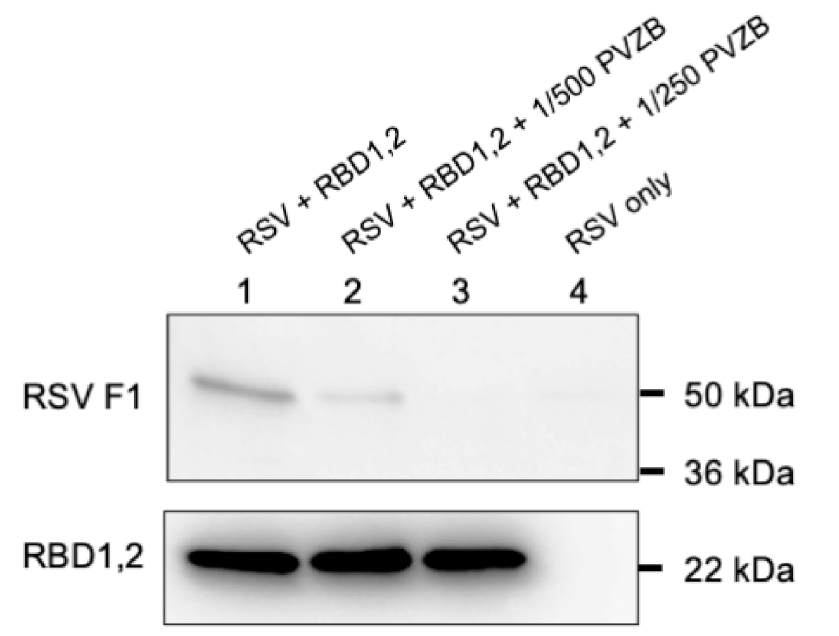
Figure 2. RSV co-immunoprecipitation by RBD1,2 is inhibited by Palivizumab. Adding increasing concentrations of the anti-RSV-F antibody Palivizumab inhibits this interaction (lanes 1, 2 and 3). Lane 4 is an RSV-only control. RSV-F1 protein is detected using NCL-RSV3 primary antibody and RBD1,2 with D6 anti-nucleolin monoclonal antibody. This experiment was repeated 4 times.